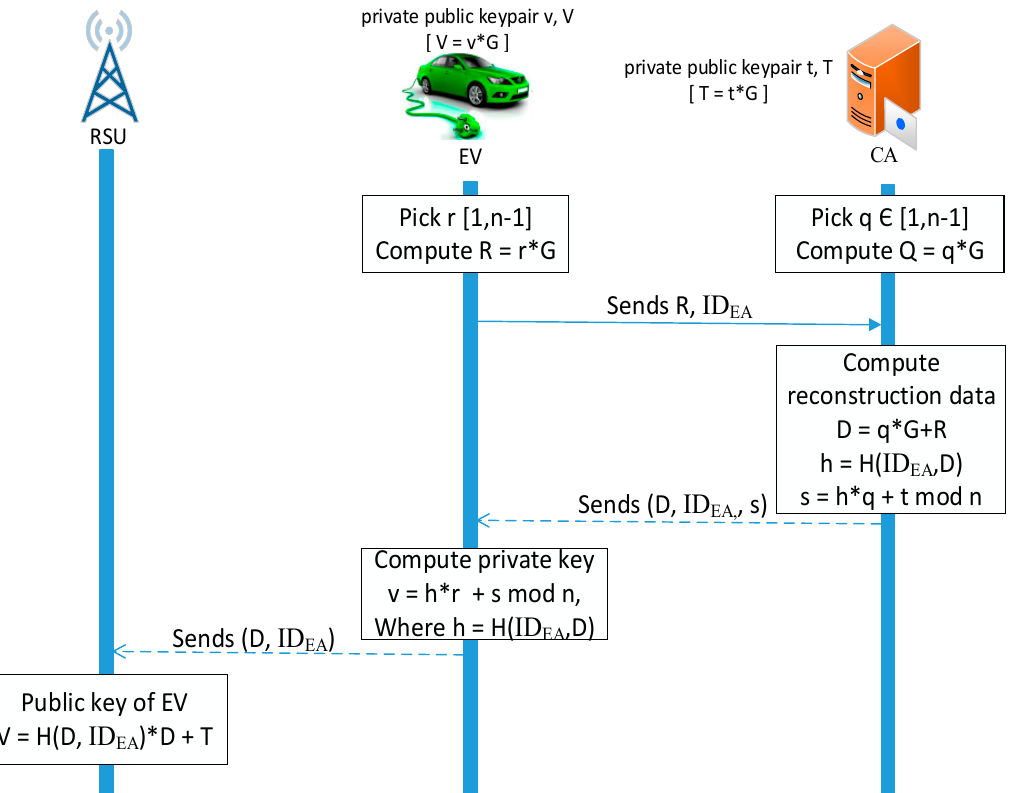
Figure 8. Implicit certificate mechanism using elliptic curve cryptography (ECC).